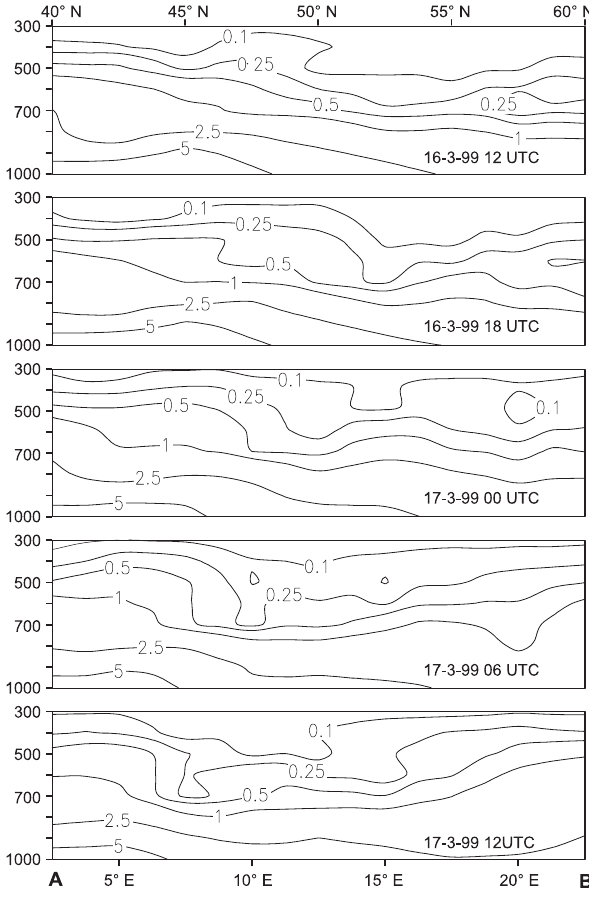
Fig. 15. Series of cross sections of specific humidity [g/kg] along the line indicated in Figs. 11 to 13 from the surface to the 300 hPa level from NCEP/NCAR reanalysis